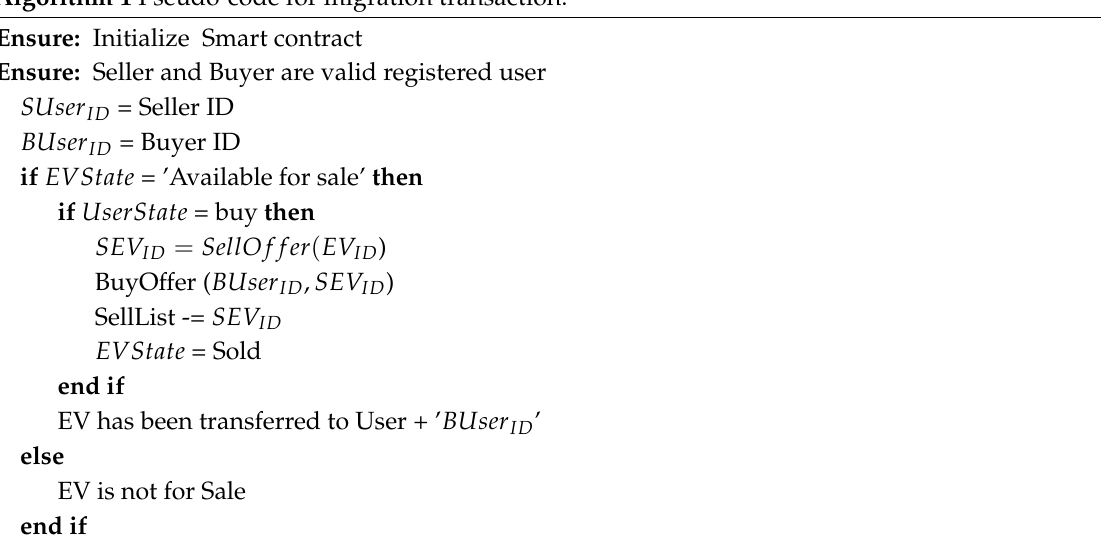
Algorithm 1 Pseudo-code for migration